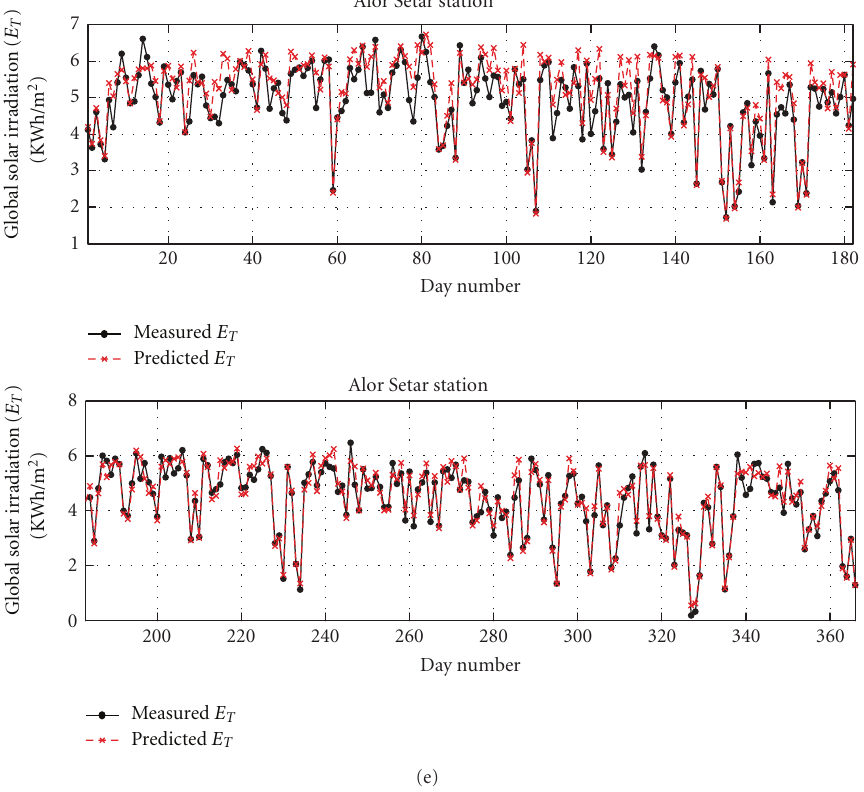
Figure 6: Comparison between the measured and predicted daily global radiation for the chosen five